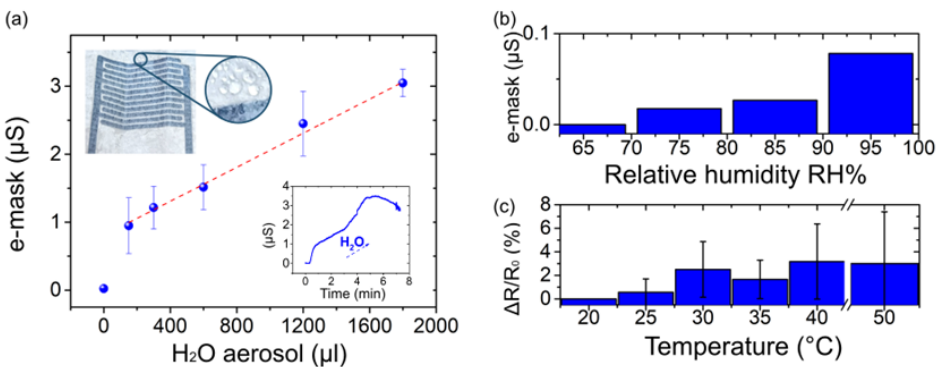
Figure 2. E-mask characterization. ( a ) E-mask calibration curve with respect to H 2 O aerosol flow. Error bars represent the standard error over three measurements; the dotted red line is the linear fit. Top-left inset shows the damp sensor with the zoom on the condensed water droplets formation. Bottom-right inset shows the e-mask time response to aerosol flow (rate of 300 μL/min). ( b ) E-mask signal output (μS) variation with respect to the relative humidity (RH varies from 65% to 95%). ( c ) Electrical resistance variation (%) of printed PEDOT:PSS lines with respect to the temperature increase (from 20 °C to 50 °C).